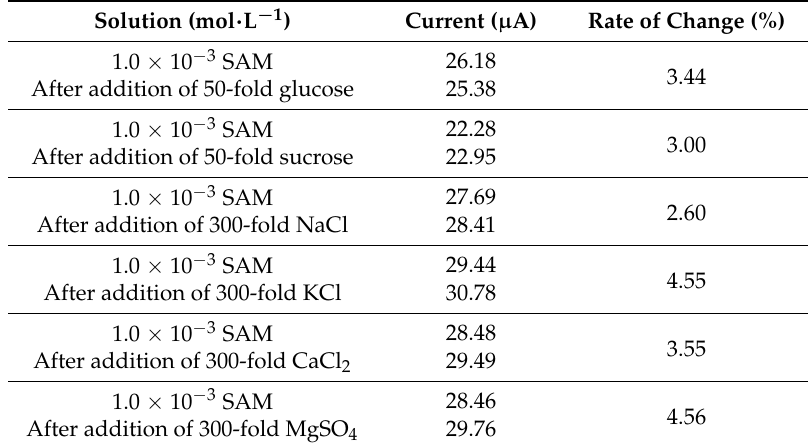
Table 2. Effects of interfering substances on the determination of SAM solution of 1 × 10 − 3 mol · L − 1 by